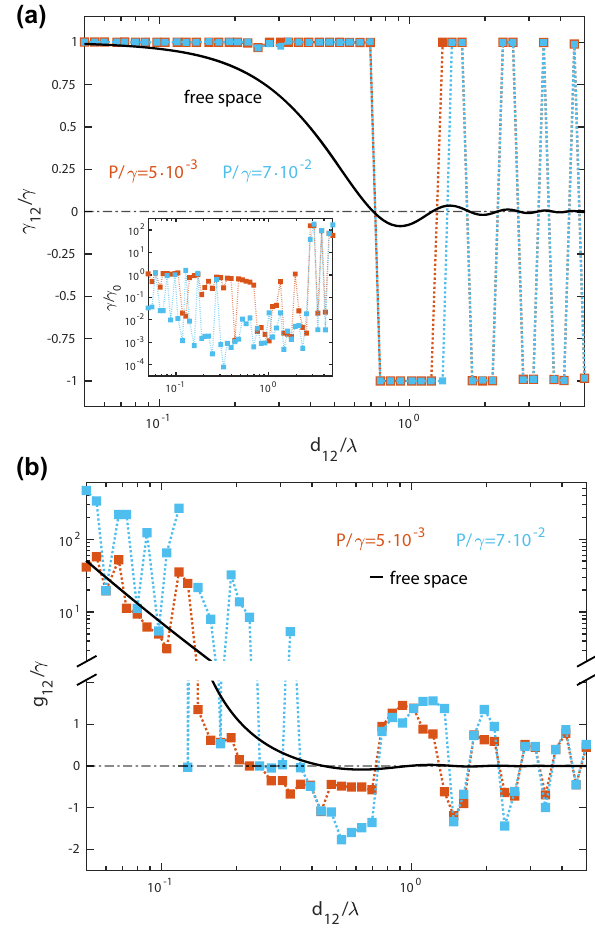
Figure 4: Optimized master equation parameters. (a) Dissipative coupling strength normalized to the QE decay rate as a function of the inter-emitter distance for the two pumping rates in Figure 2(b and c). The inset plots the purcell factor versus d the main panel. (b) Normalized coherent coupling strength for the same ID structures. The black solid lines in both panels correspond to free-space